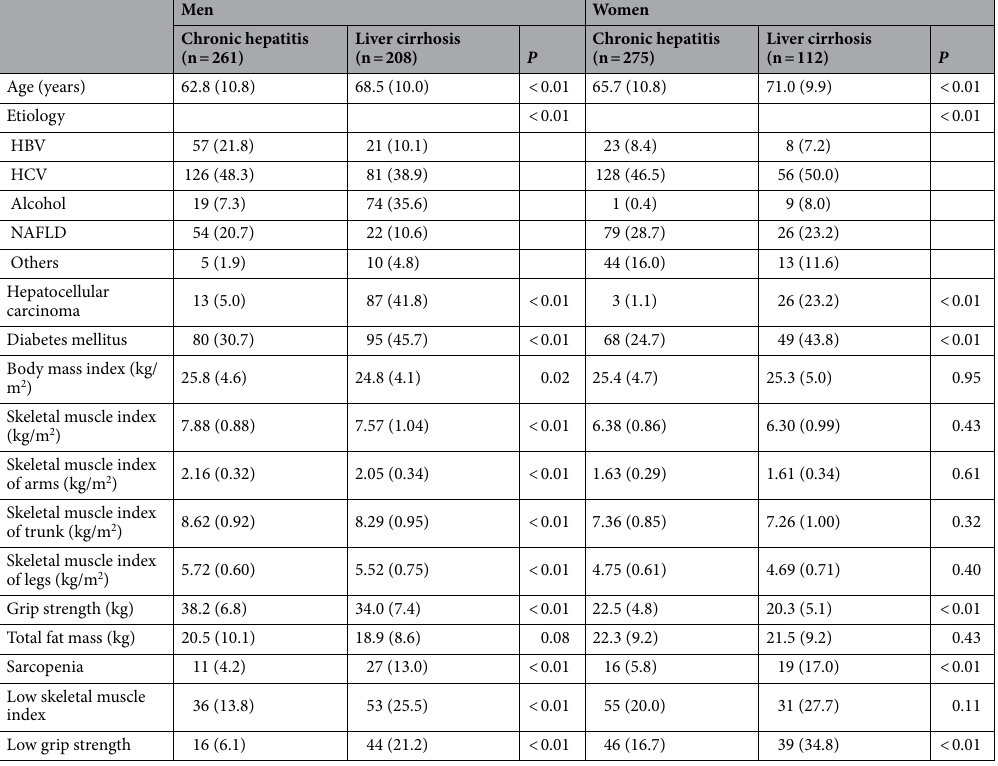
Table 2. The comparison of patients with chronic hepatitis and liver cirrhosis. Values are presented as the mean (SD) or number (%). HBV, hepatitis B virus; HCV, hepatitis C virus; NAFLD, nonalcoholic fatty liver